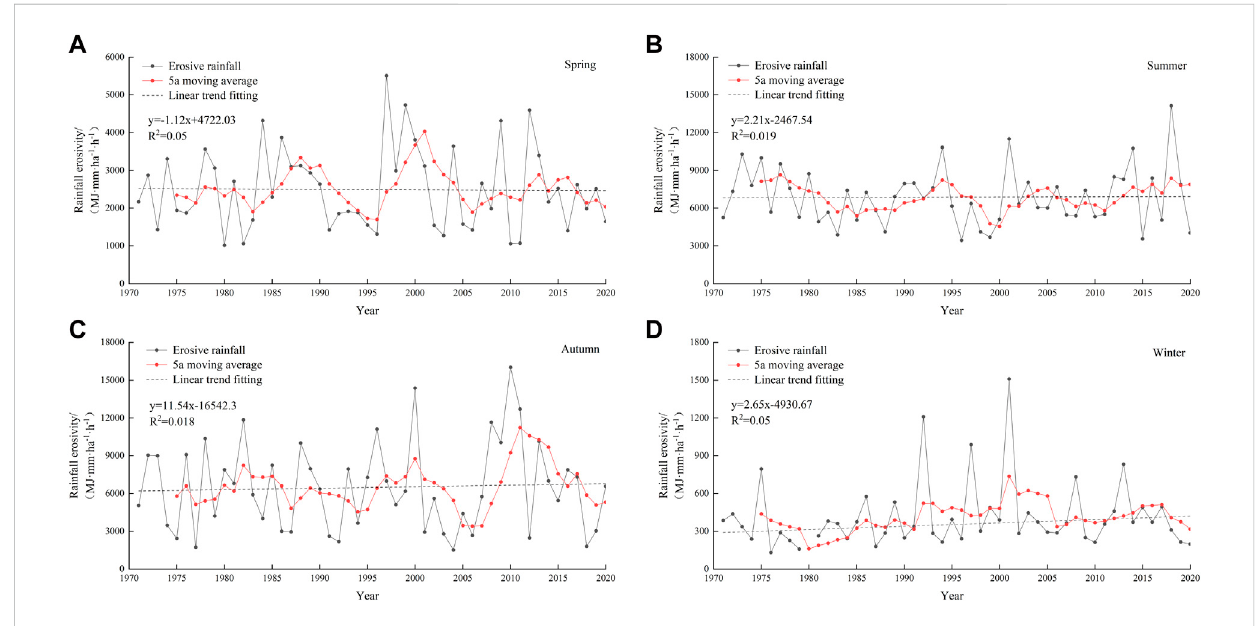
Seasonal variation in rainfall erosivity in the Nandu River Basin.